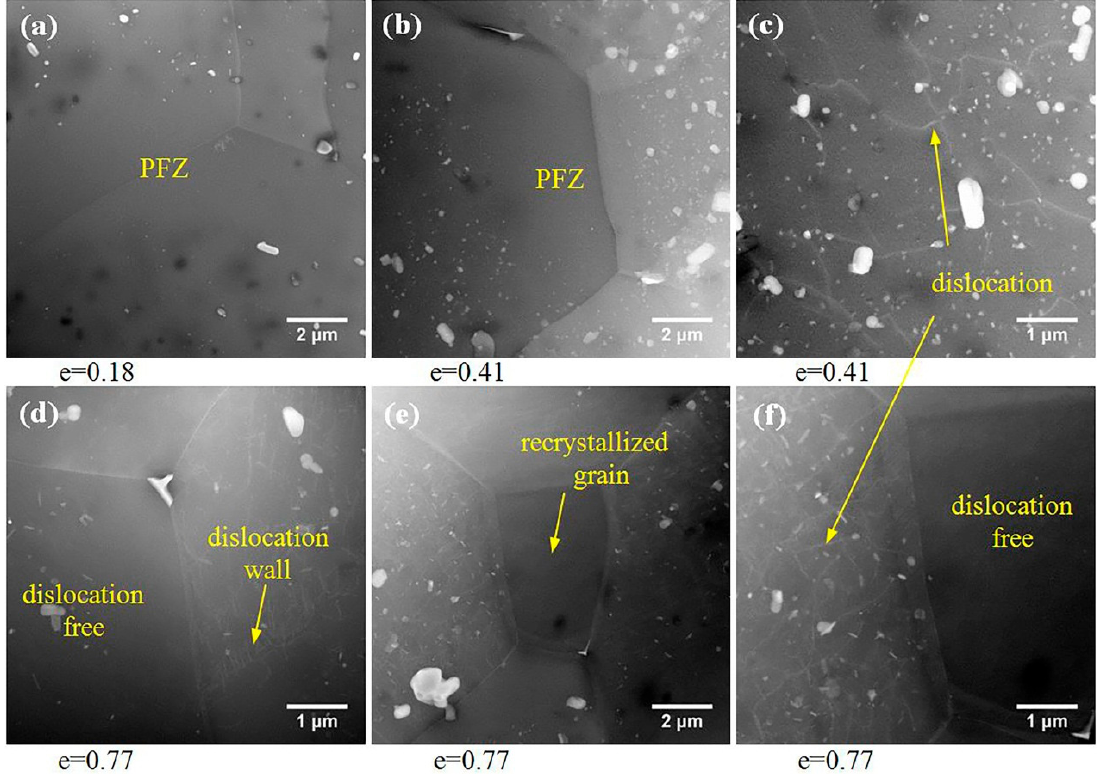
Figure 6. The evolution of the HAADF-STEM structure during superplastic deformation at 490 °C and 2 × 10 − 4 s − 1 . PFZ: particle-free zone.